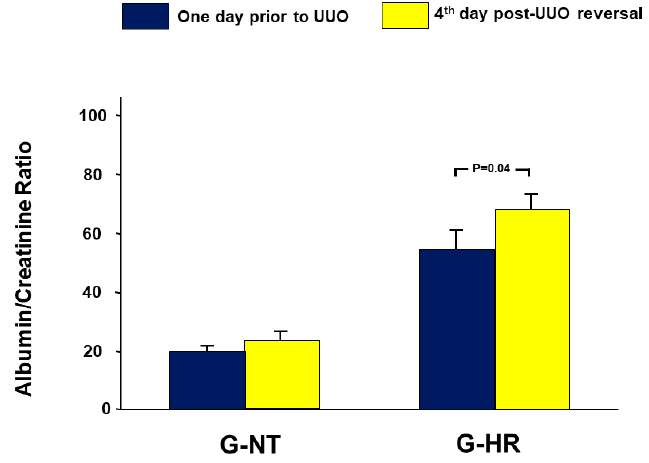
Figure 1. The albumin-creatinine ratio (ACR) one day prior to the creation of UUO (baseline value) and in the fourth day following the reversal of the UUO. Values represent the mean ± SEM.